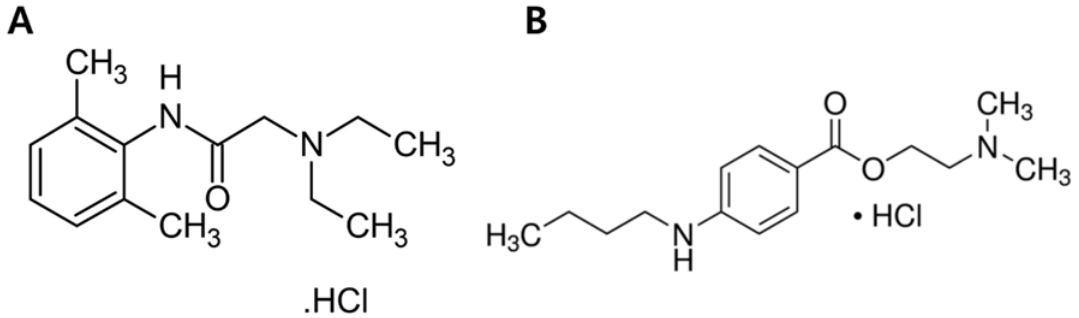
Figure 1. Chemical structure of LAs ( A ) Lidocaine, ( B )